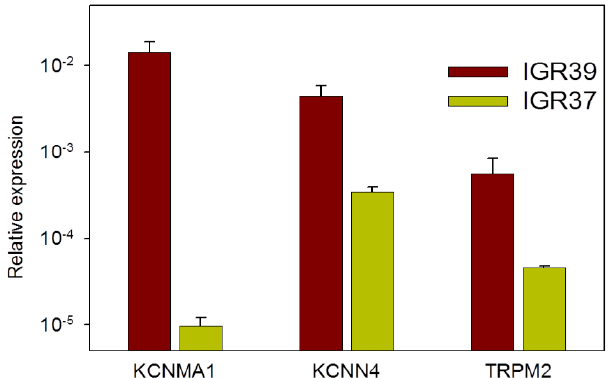
Figure 10. Expression of KCNMA1 , TRPM2 , and KCNN4 in primary and metastatic melanoma cell lines. Expression is relative to that of the housekeeping genes actin or GAPDH ( n = 2–3 experiments, each run in triplicate; see Materials and Methods).